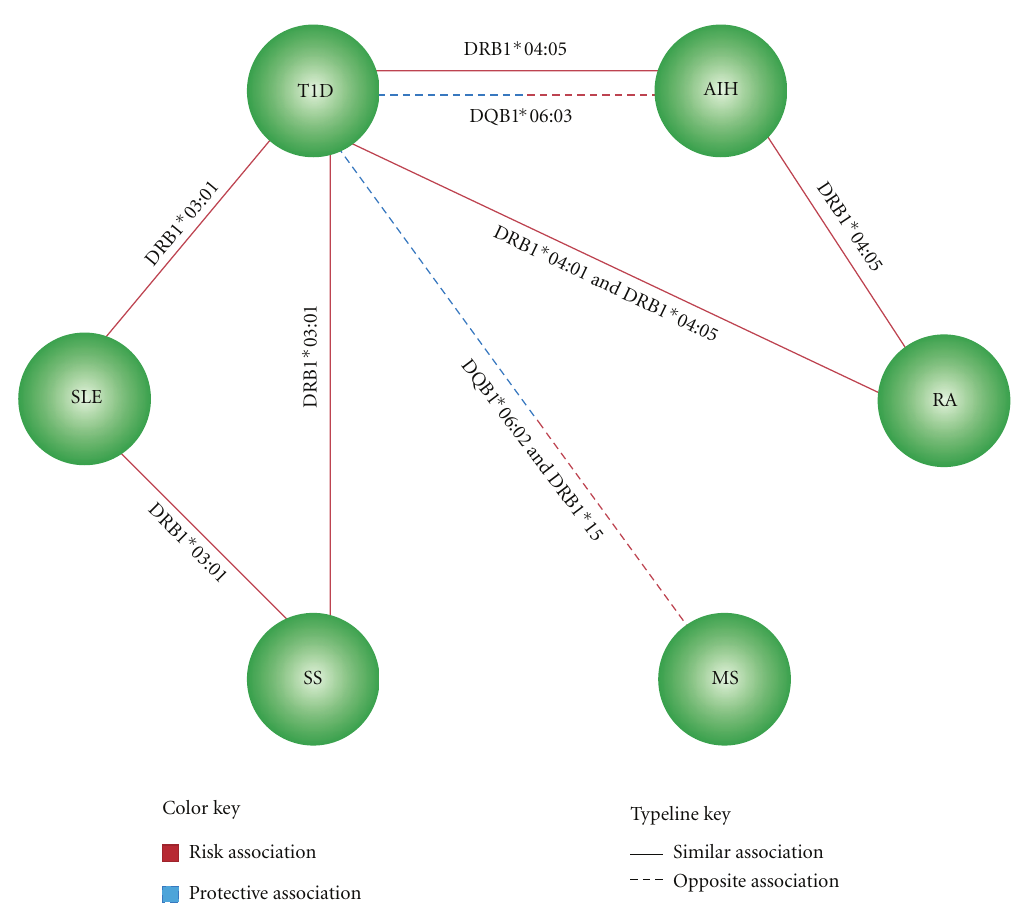
Figure 3: The complex interplay of HLA in six autoimmune diseases in Latin